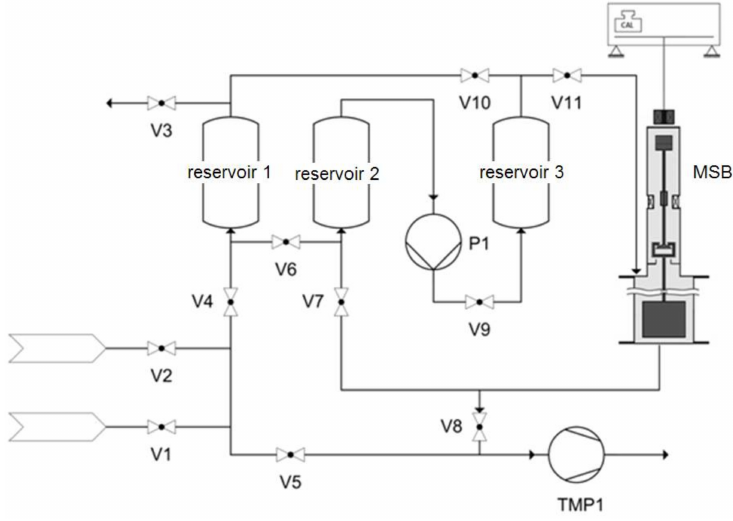
Figure 8. Schematic view of a manometric-gravimetric adsorption